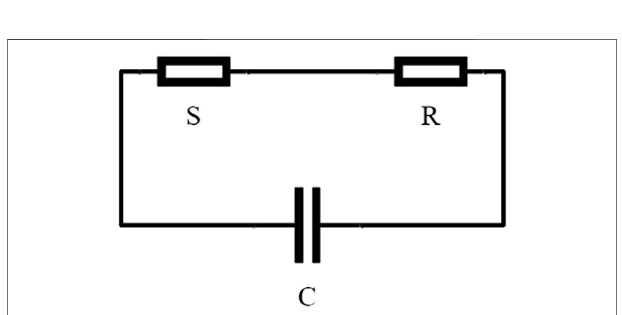
FIGURE 2 | Equivalent circuit of biological tissue. Bioimpedance is equivalent to a three-element circuit composed of only resistance and